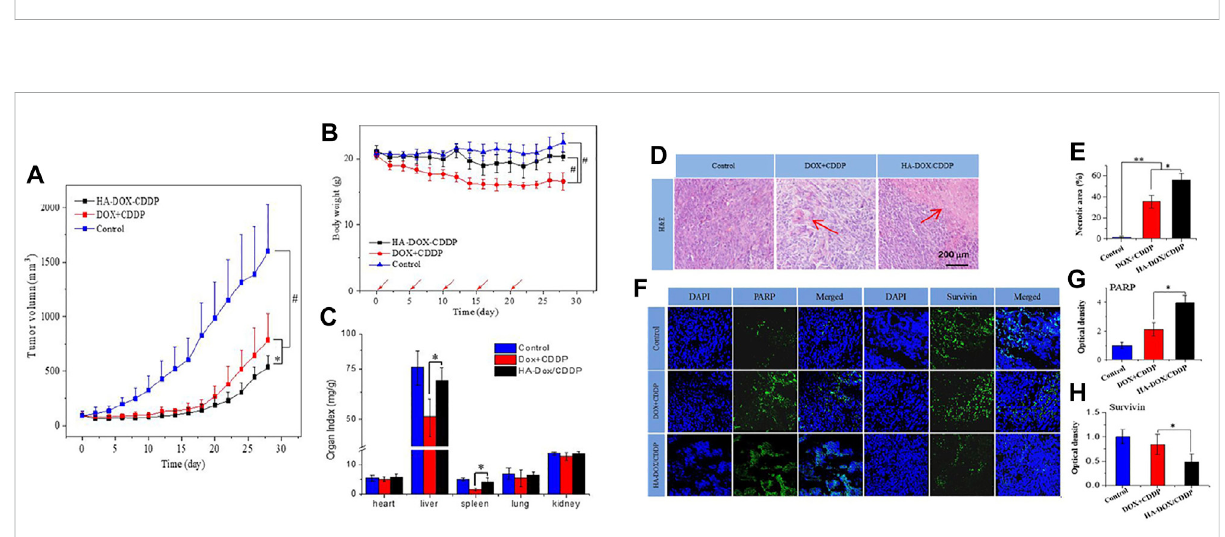
FIGURE 4 Invivo safetyandantitumoref fi cacies. (A) Tumorvolumesand (B) bodyweightsof4T1-xenograftedmiceaftertreatmentwithNSasthecontrol, DOX + CDDP, or HA-DOX-CDDP. Red arrows showed the tail-veil injection time. (C) Organ coef fi cients of isolated organs in NS, DOX + CDDP, or HA-DOX-CDDPtreatedgroups(* p < 0.05,# p < 0.001).Histopathologyandimmuno fl uorescenceanalyses. (D) Histopathological(H&E)analysesand (E) necrotic areas inH&E-stained tumorsectionsfrom 4T1-xenograftedmice followingtreatmentwith NSas thecontrol, DOX+ CDDP, or HA- DOX-CDDP. Red arrows indicated the necrotic area. (F) Immunohistochemical (PARP and survivin) analyses of tumor tissue sections following treatment with NS as the control, DOX + CDDP, or HA-DOX-CDDP. (G) Relative optical densities of tumor sections showing PARP immuno fl uorescence. (H) Relative optical densities of tumor sections showing survivin immuno fl uorescence (Data are presented as the mean ± SD ( n = 5). * p < 0.05, ** p < 0.01). Reproduced with permission from ref (Owen et al., 2012). CC BY 4.0. Copyright 2020 The